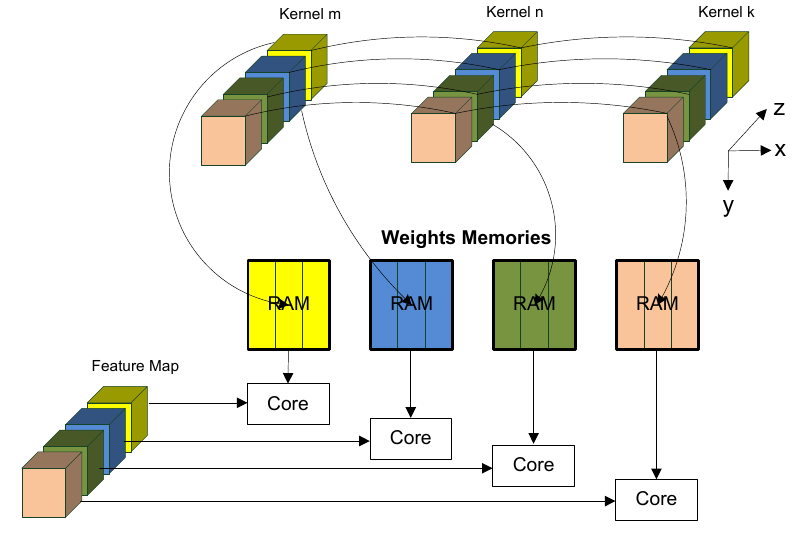
Figure 4. Partition of kernels across several weight